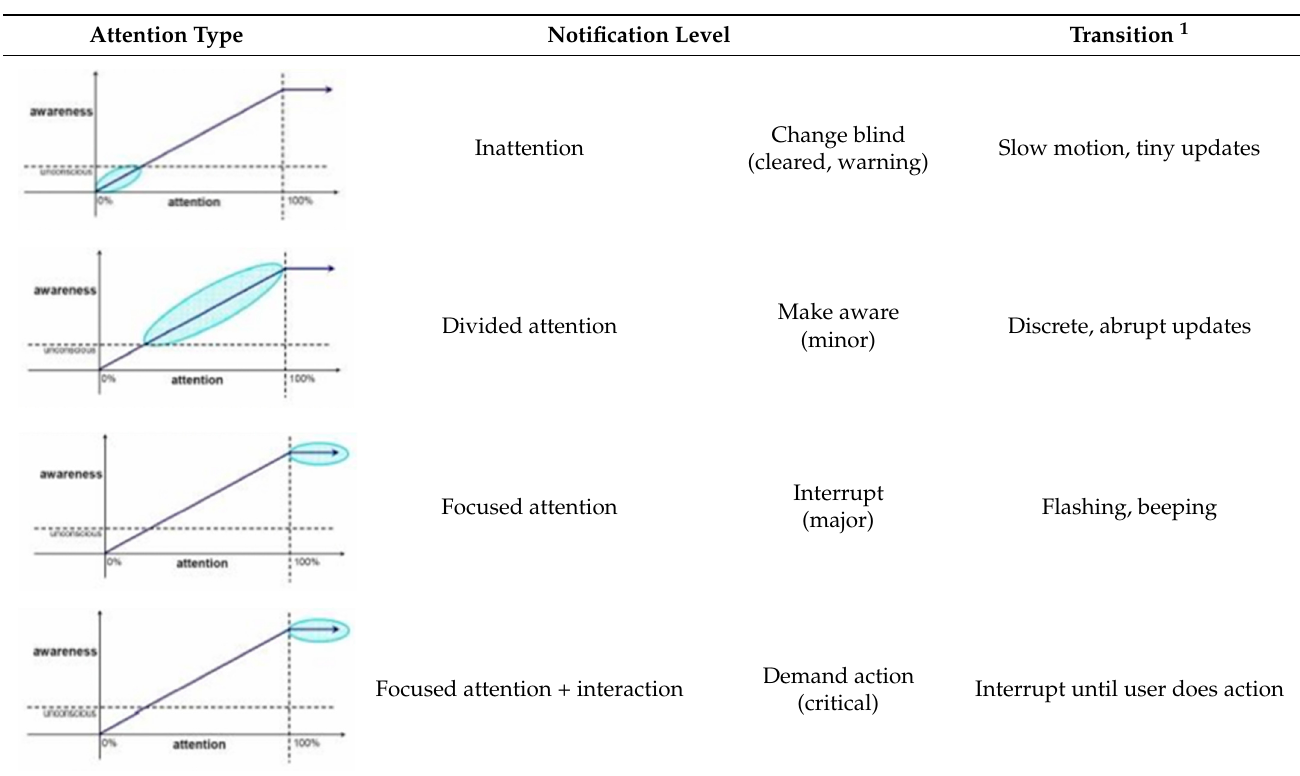
Figure 5. Mapping severity levels onto the attention-awareness graph. Table 5. Mapping severity levels to attention types/transition types of [38].